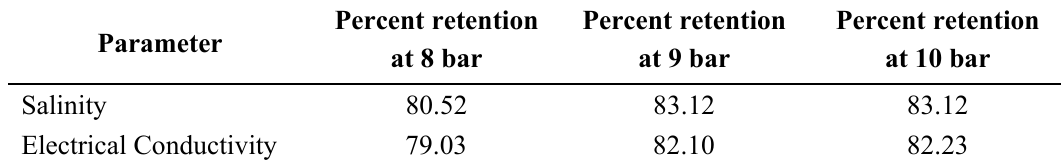
Table 7. Retention percentage (% R ) of salinity and electrical conductivity at various pressures for Sample 1.